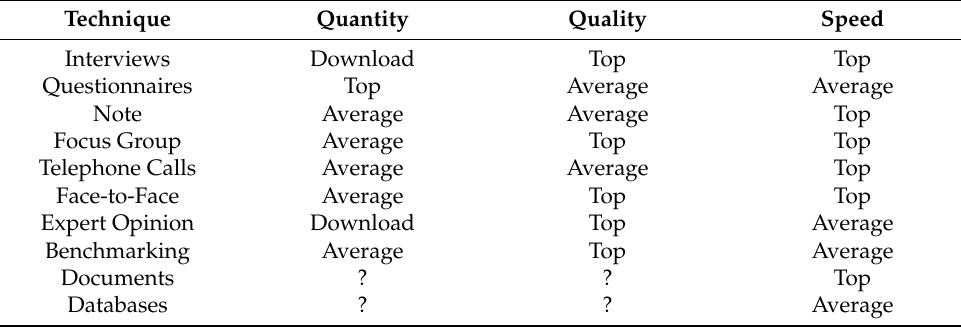
Table 2. Summary of Data Collection Techniques adapted from